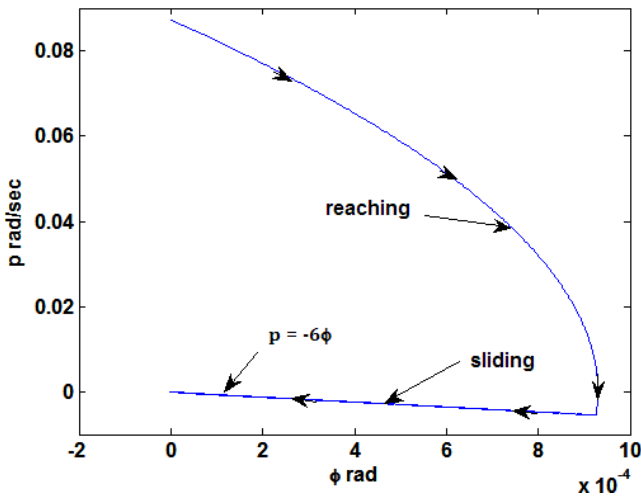
Figure 4. Reaching and sliding behavior in the p